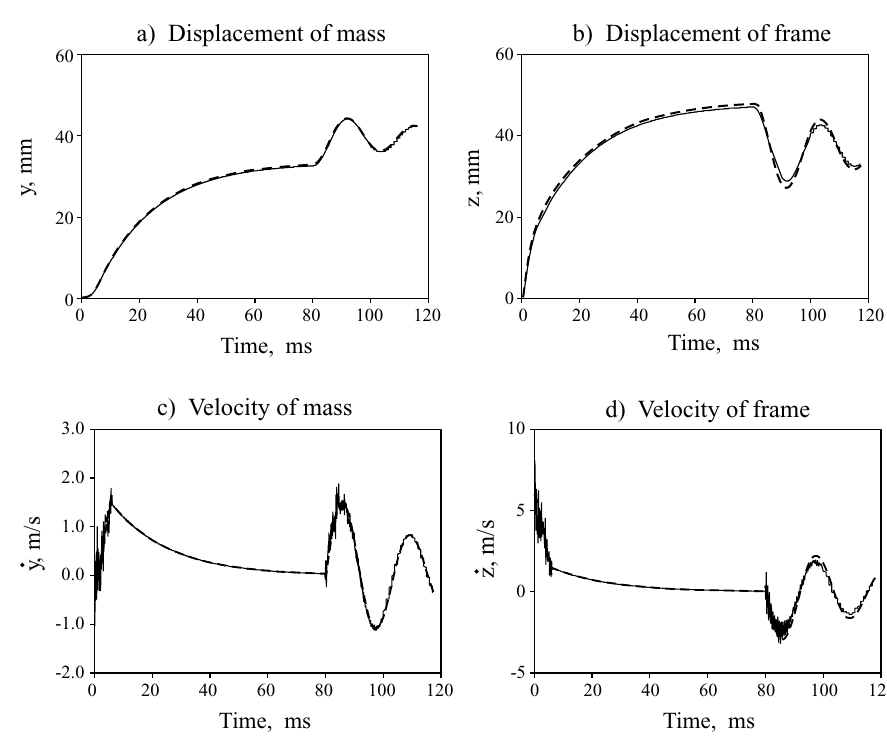
Fig. 6. Comparison of analytical computation of displacements and velocities with numerical results. —— LS-Dyna, − − −